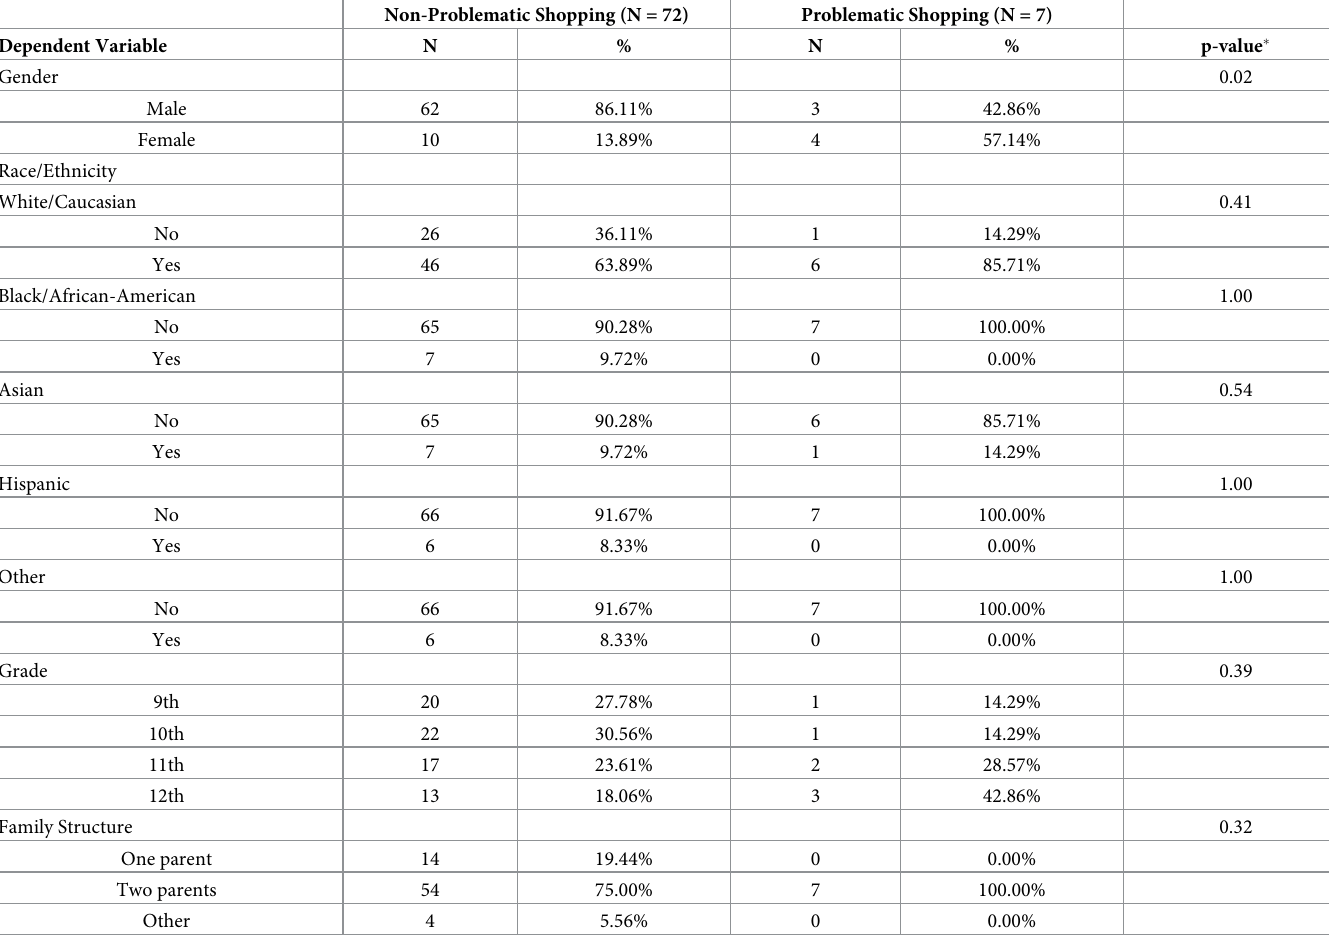
Table 3. Sociodemographic characteristics of adolescents with problematic video gaming stratified by problematic-shopping status.